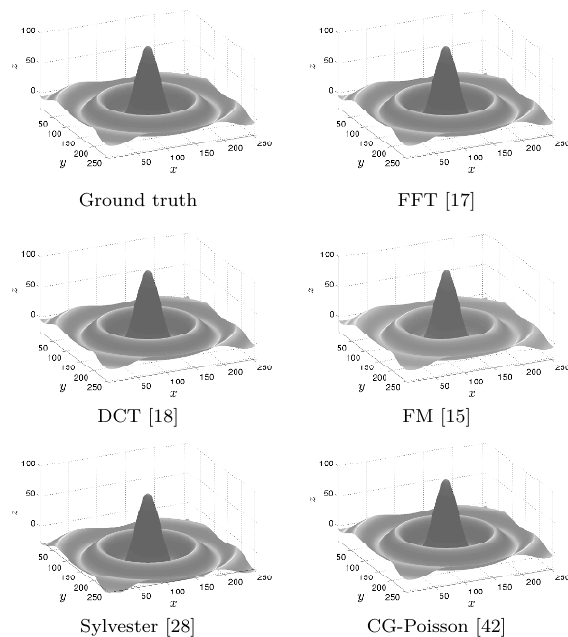
Fig. 3 Results on the “Sombrero” dataset (cf. Table 2).